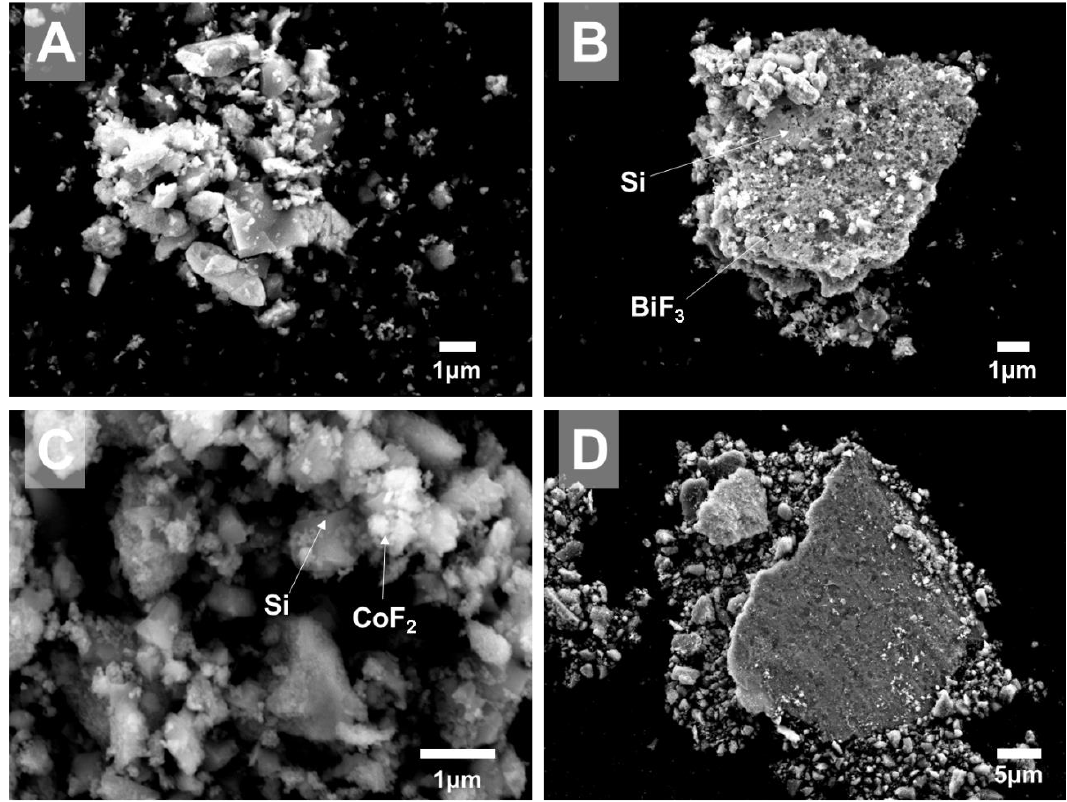
Figure 2. Secondary electron images of as milled 30 wt.% silicon-70 wt.% fluoride composites: ( A , B ) 30Si · 70BiF 3 and ( C , D ) 30Si · 70CoF 2 .